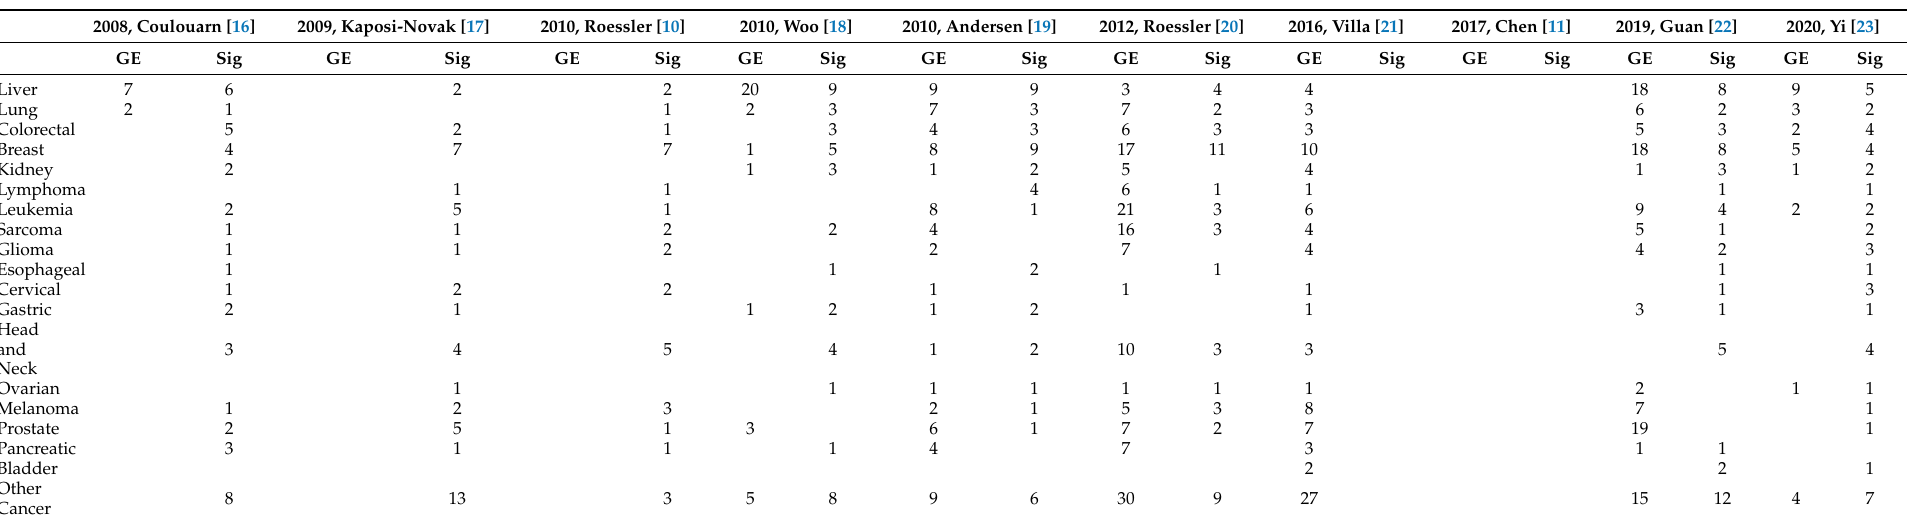
Table 3. GENEVA and Sigcom LINCS results of HCC gene